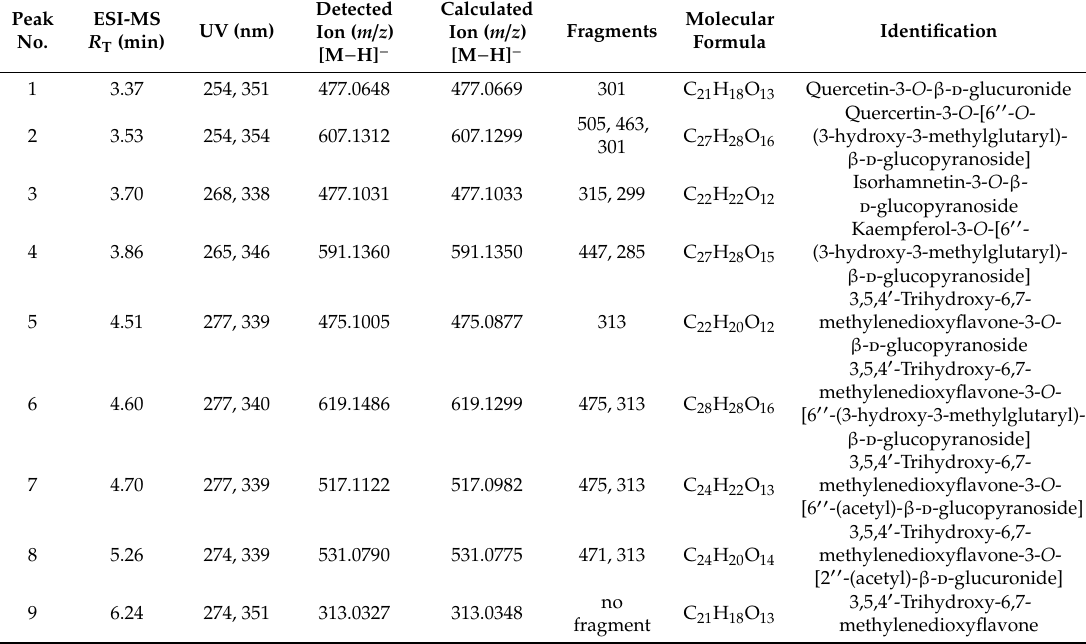
Table 1. Constituents of PT analyzed via UPLC–QTofMS